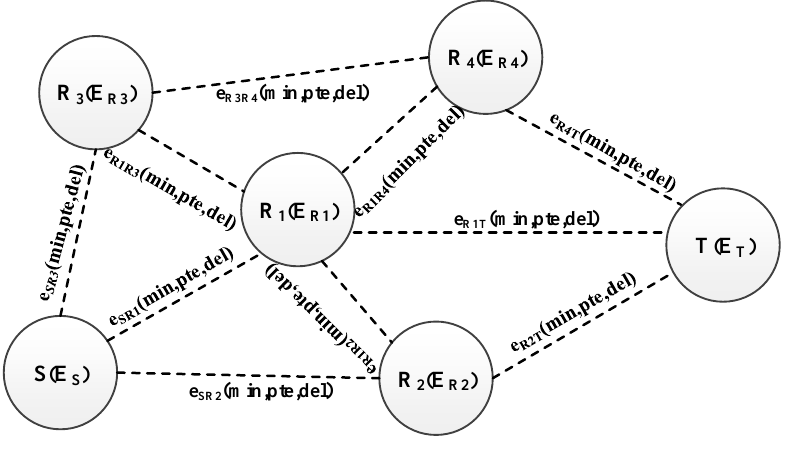
Figure 6. Energy link optimization